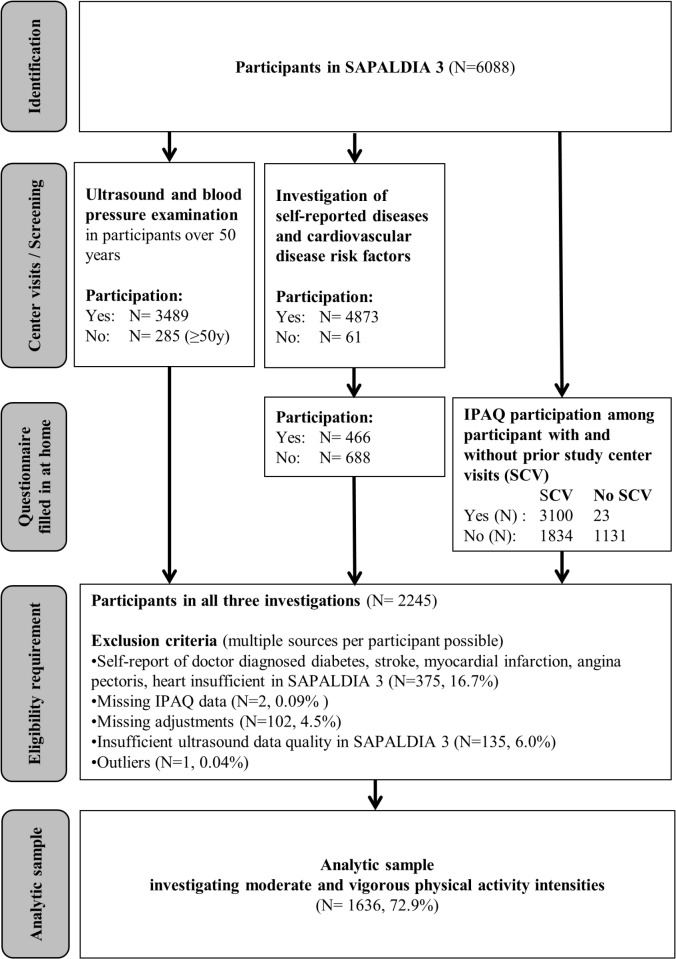
Flow chart of subject inclusion.SCV = prior study center visits, IPAQ = International Physical Activity Questionnaire, PA = physical activity, affected adjustments = body mass index, mean arterial pressure, heart rate, smoking.